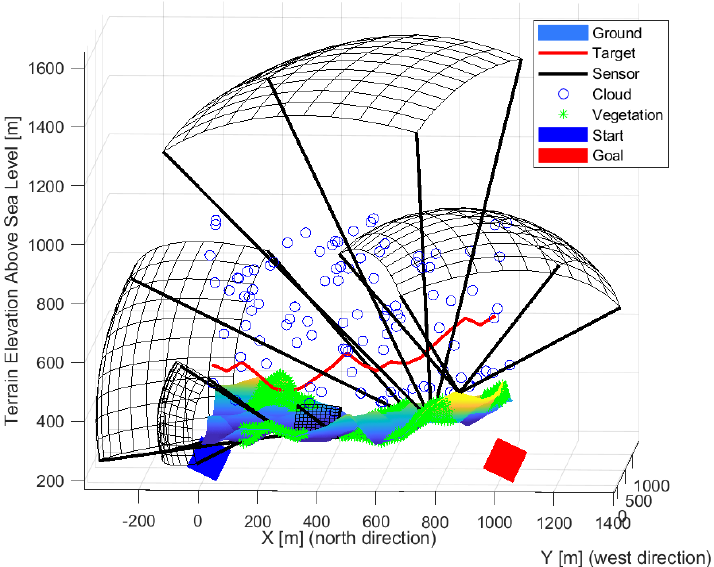
Figure 16. The solution in the case of the five sensors from the side view.